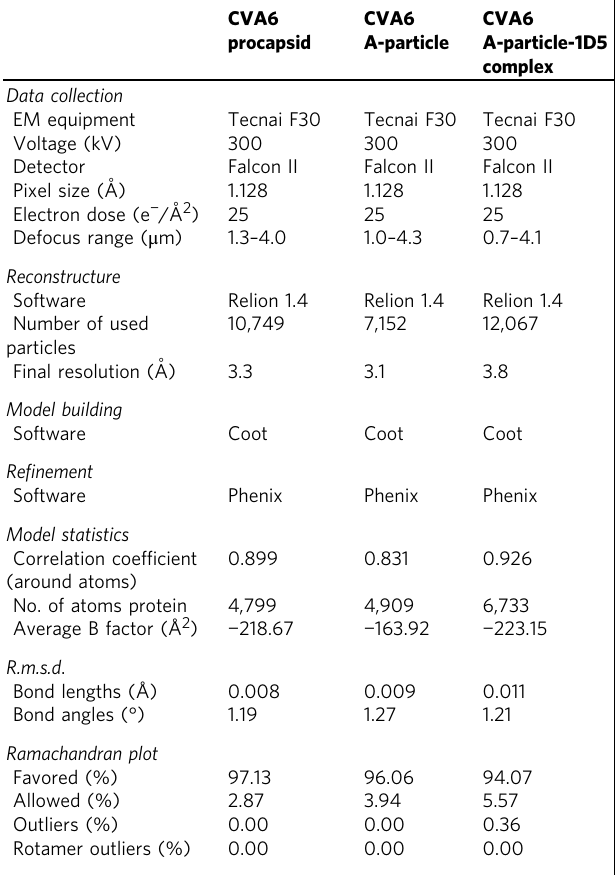
Table 1 CryoEM data collection and atomic models re fi nement